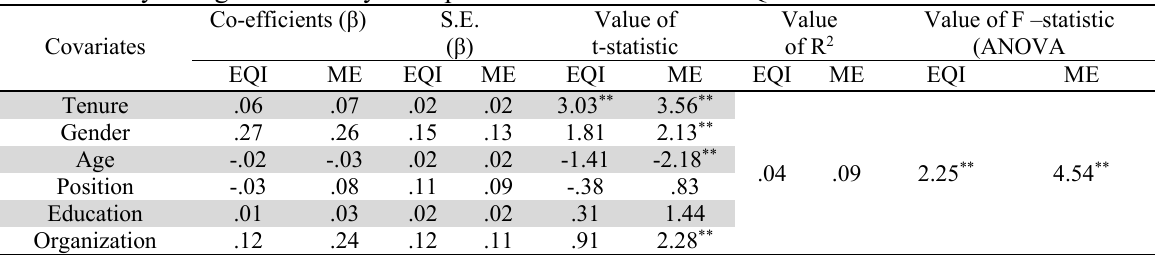
The summary of regression analysis of potential covariates with EQI and ME Co-efficients ( β ) Covariates Gender